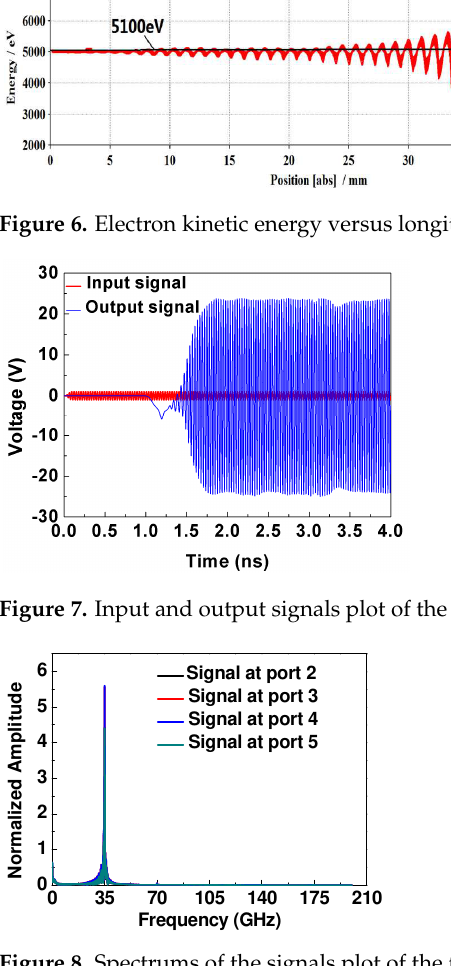
Figure 8. Spectrums of the signals plot of the four output ports.